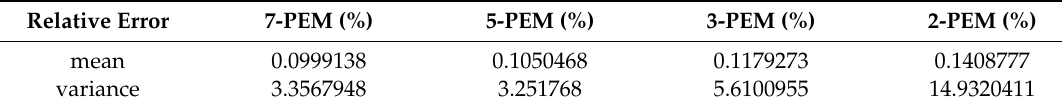
Table 3. Average relative error of the power network.